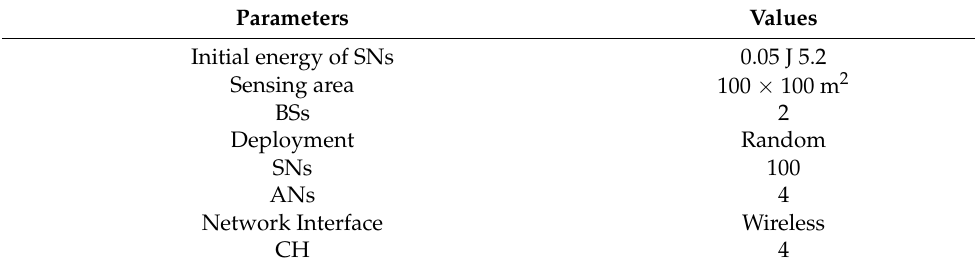
Table 1. Simulation parameters.